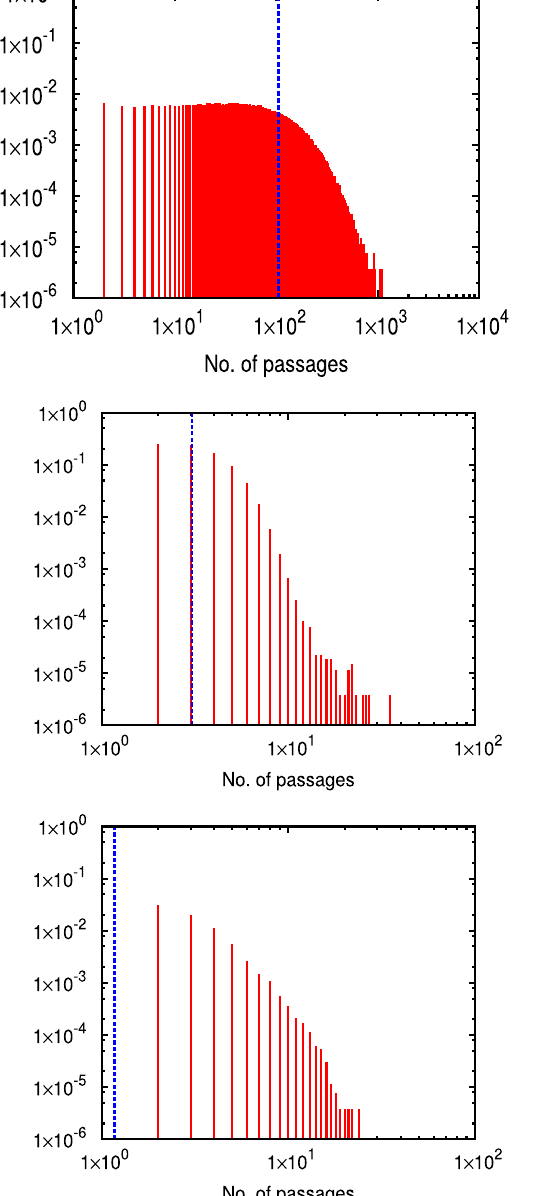
FIG. 5. Distribution of the number of photon passages till absorption without (top) and with a sawtooth chamber (bottom) and an inverted sawtooth (center). The blue line represents the mean number of passages.